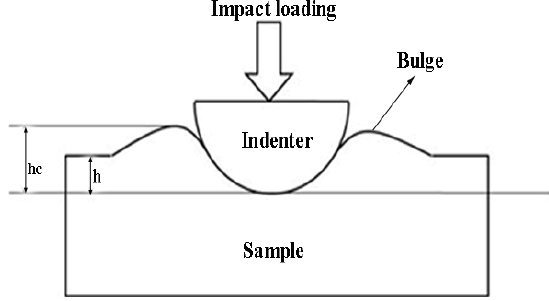
Figure 7: Cross-section of Indentation micromorphology